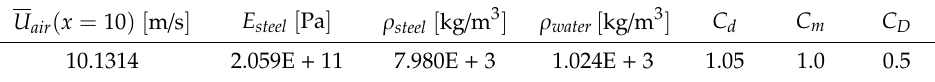
Table 1. A list of the model parameters used for the numerical simulation.